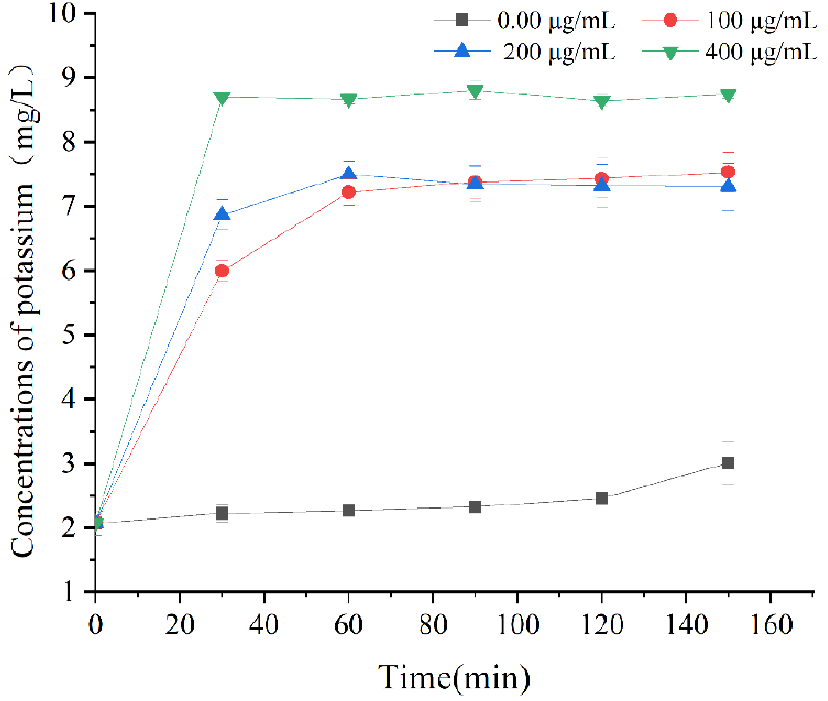
Figure 3. Effects of juglone on the release of potassium. Error bars indicate the standard deviation of three technical replicates ( n = 3).